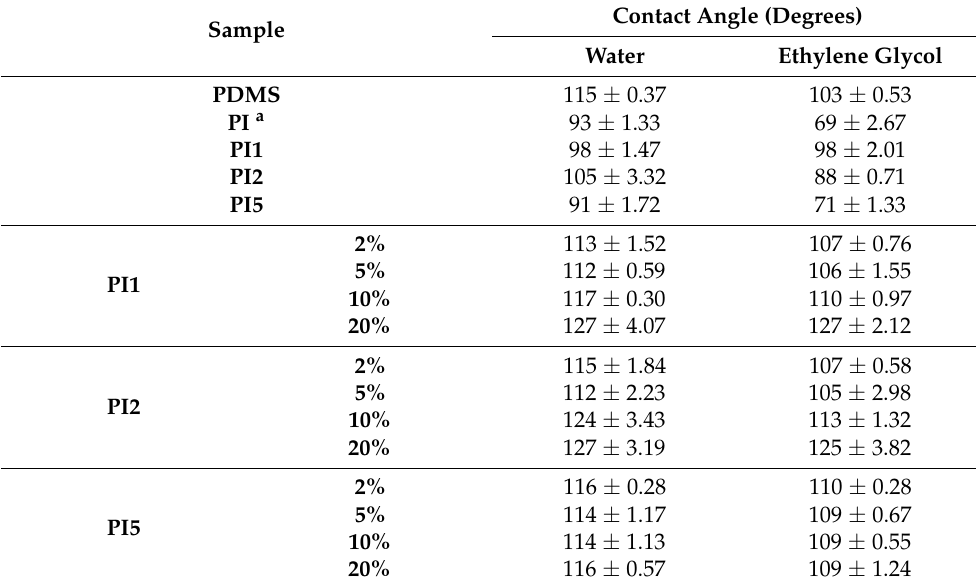
Table 2. Water and ethylene glycol contact angle values for composite films. Contact Angle (Degrees) Sample Water Ethylene Glycol PDMS 115 ± 0.37 103 ± 0.53 PI